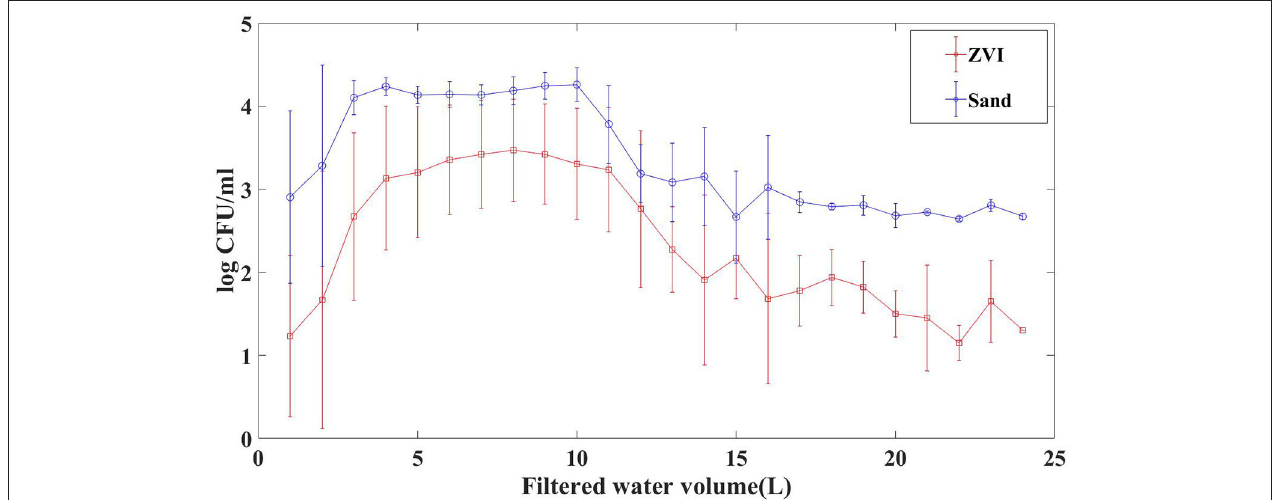
FIGURE 3 | Mean E. coli populations (log CFU/mL) in each liter ( n = 24) of ZVI-sand or sand-filtered effluent from six laboratory trials. E. coli TVS 353 was inoculated at 4 log CFU/mL before filtration events. TABLE 2 | The reduction of E. coli TVS 353 by ZVI-sand and sand filtration in each of the six individual trials as shown by percentage or log CFU/ml reduction. Reduction of E. coli by filtration ZVI-sand filter Sand filter Trial